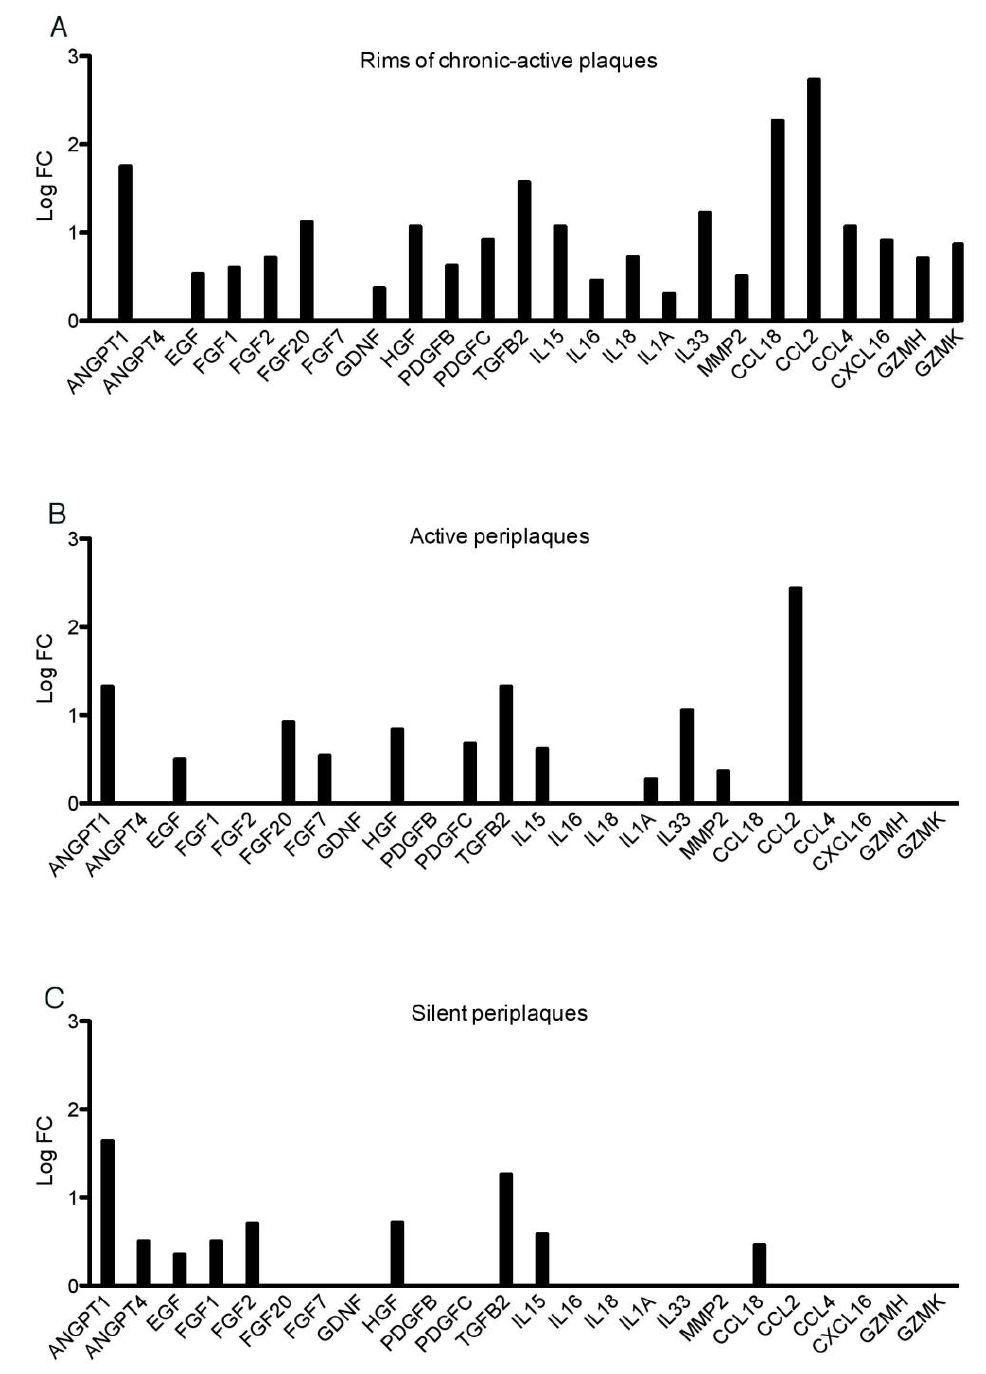
Figure 2. Cytokine, chemokine and growth factor genes overexpressed in rims and periplaques compared with control white matter.